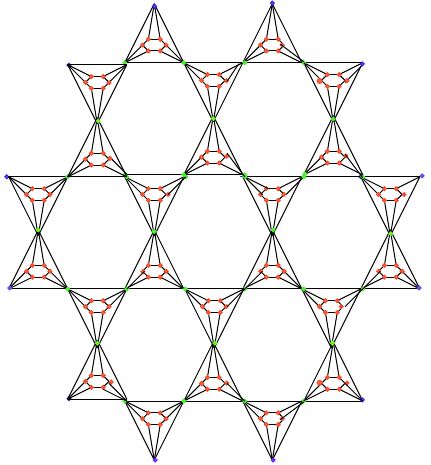
Figure 1. Benzenoid planar octahedron network BPOH ( 2 ) .